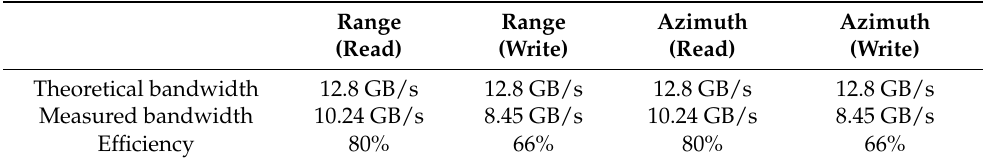
Table 5. Measured bandwidth of the method